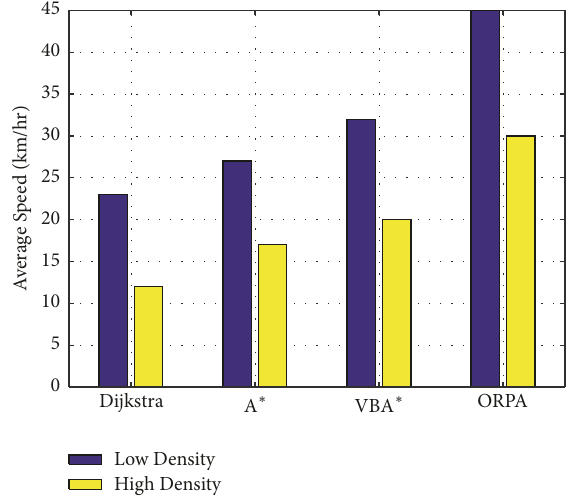
Figure 6: Average ambulance speed in low- and